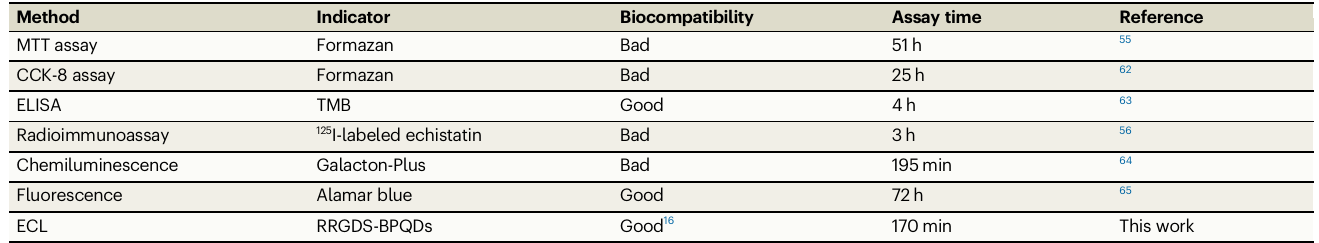
Table 2 | Analytical performance of biosensors for IC50 determination of cyclo(RGDyK) or its